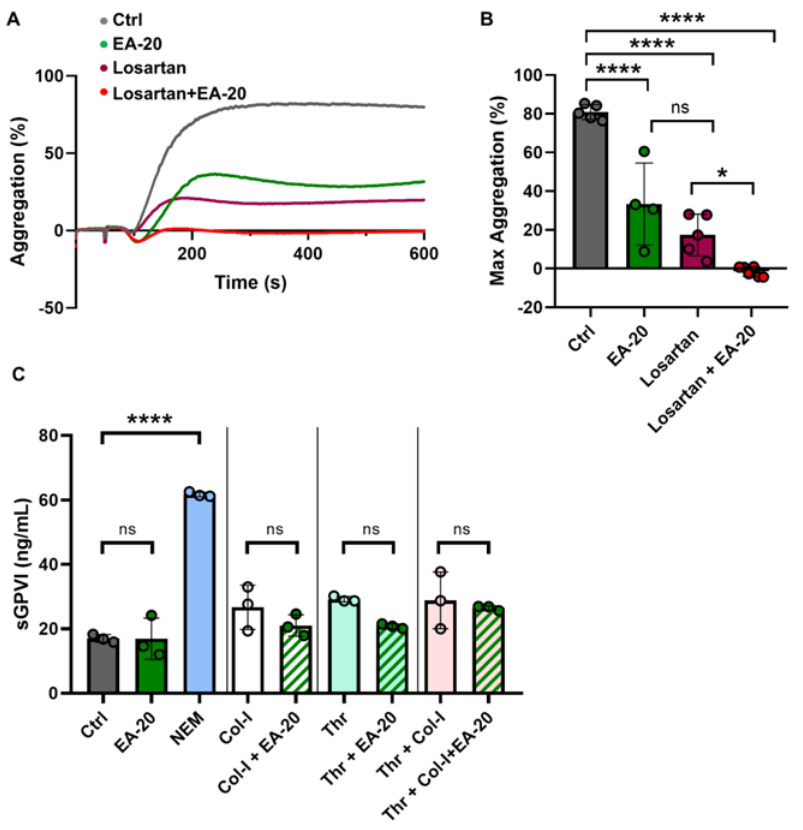
Figure 5. EA-20 antibody does not induce clustering or shedding of GPVI. ( A , B ) Washed human platelets were stimulated with Col-I (2.5 µ g/mL) in the presence of control IgG (Ctrl) or EA-20 antibody and/or Losartan (50 µ M). Platelet aggregation was measured using light transmission aggregometry and recorded for 10 min. Representative aggregation curves are shown. ( C ) Human PRP were stimulated with Col-I (10 µ g/mL), thrombin (1U), a combination of Col-I (10 µ g/mL) and thrombin (1U), or GPVI shedding-inducing-reagent NEM (2 mM), in the absence or presence of EA-20 antibody. After 1 h incubation, platelet-free plasma (PFP) was collected and soluble GPVI (sGPVI) levels, indicative of platelet GPVI-shedding, were determined using ELISA assay. Mean ± standard deviation (SD), Ctrl (IgG control antibody), and EA-20. Each point represents one individual ( B , C ) healthy human donor. 1-way ANOVA and Tukey’s post hoc test, * p < 0.05, **** p < 0.0001; ns, not